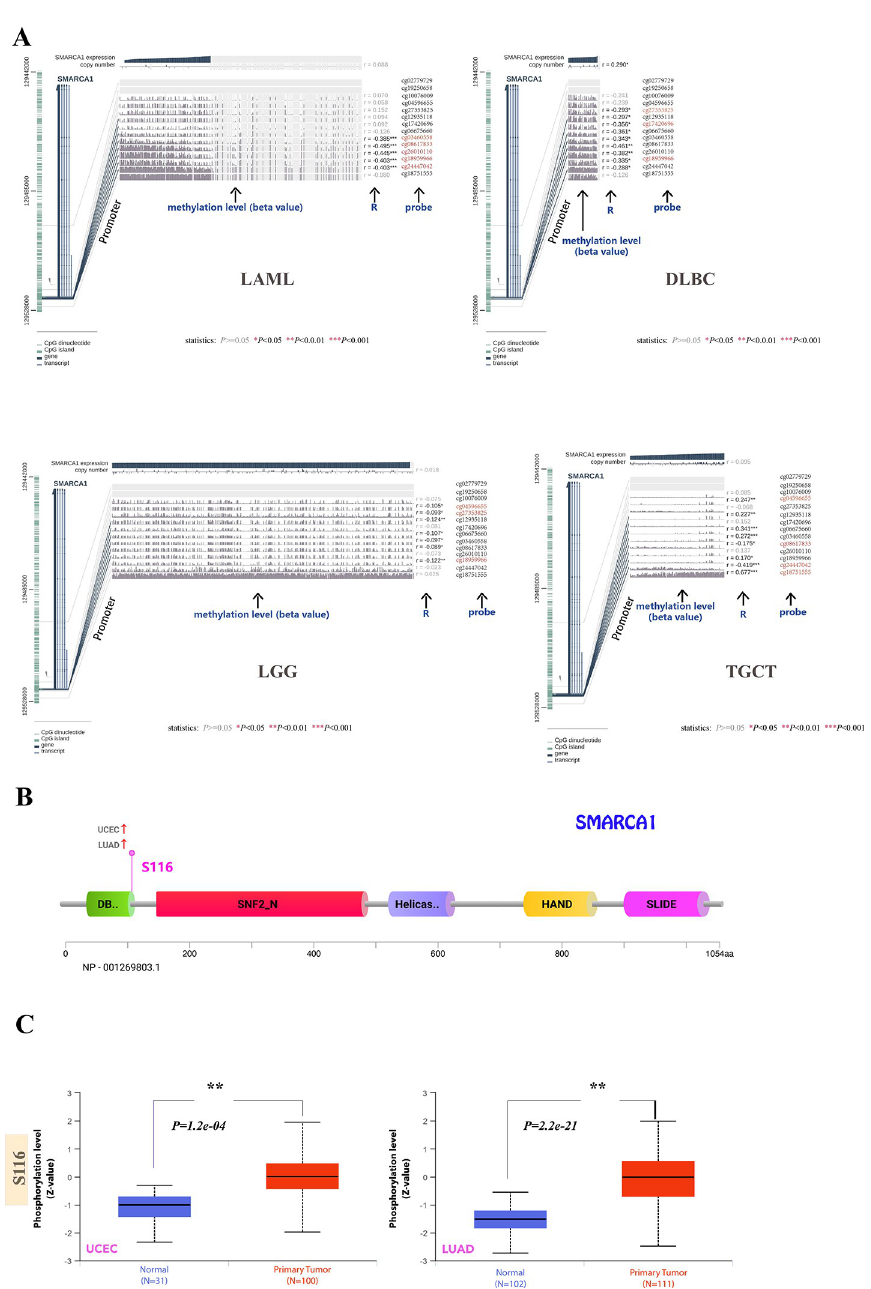
Fig 9. DNA methylation and phosphorylation analysis of SMARCA1 expression in different cancers of TCGA. (A) The correlation analysis between SMARCA1 DNA methylation and multiple cancers (LAML, LGG, DLBC, TGCT) of diverse probes was displayed with beta value, Pearson correlation coefficients (R) and Benjamini-Hochberg-adjusted P -value. (B) The structural diagram of SMARCA1 protein with positive phosphoprotein sites and cancers related. (C) comparison of phosphoprotein level between tumor and normal tissues on UCEC and